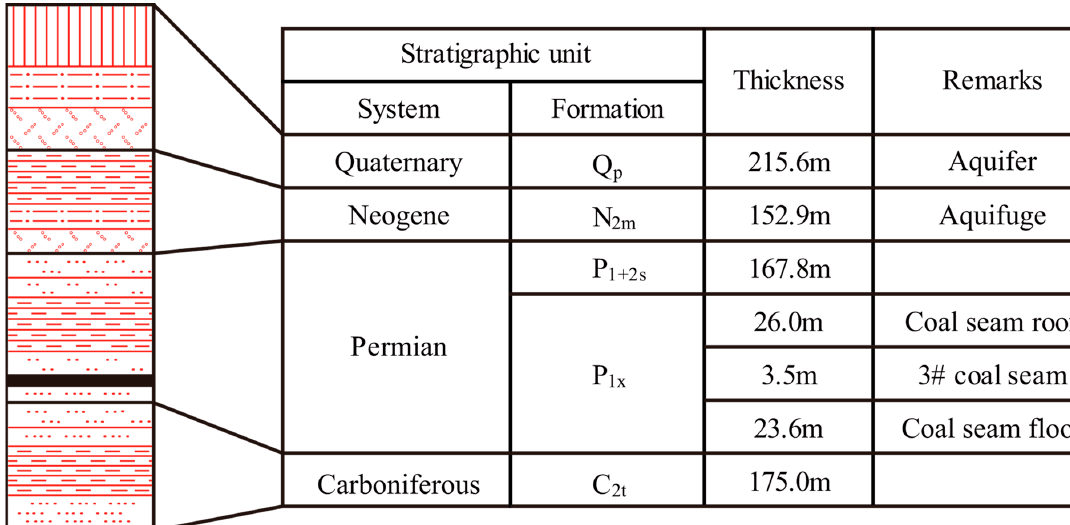
Figure 9. Stratigraphic column of the study site.